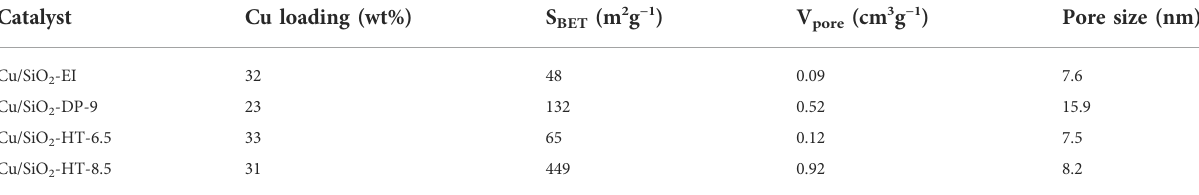
TABLE 1 Cu loading and physical properties of Cu/SiO 2 catalysts prepared by different method.